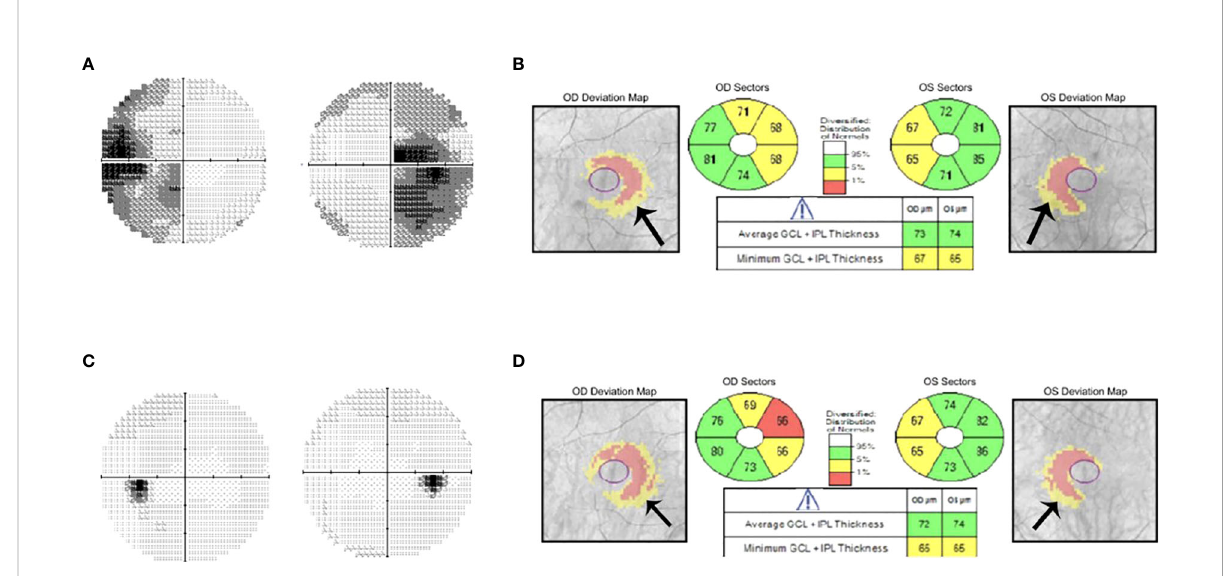
FIGURE 2 Humphrey visual fi eld 24-2 and OCT with ganglion cell analysis pre- and post-pituitary tumor surgery. (A) Humphrey visual fi eld 30-2 showing bitemporal hemianopia in a patient with a pituitary tumor and chiasmal compression. (B) Ganglion Cell Analysis of Spectral domain-OCT (Cirrus) shows binasal thinning of the ganglion cell layer with relative overall preservation, indicating a good prognosis for visual recovery following surgical excision of a pituitary tumor. (C) Follow-up visual fi eld at one month after surgical decompression of the tumor showing complete recovery of the visual fi eld defect. (D) Ganglion cell analysis at 1 month showing persistence of the binasal ganglion cell loss and the overall preservation of the ganglion cell layer